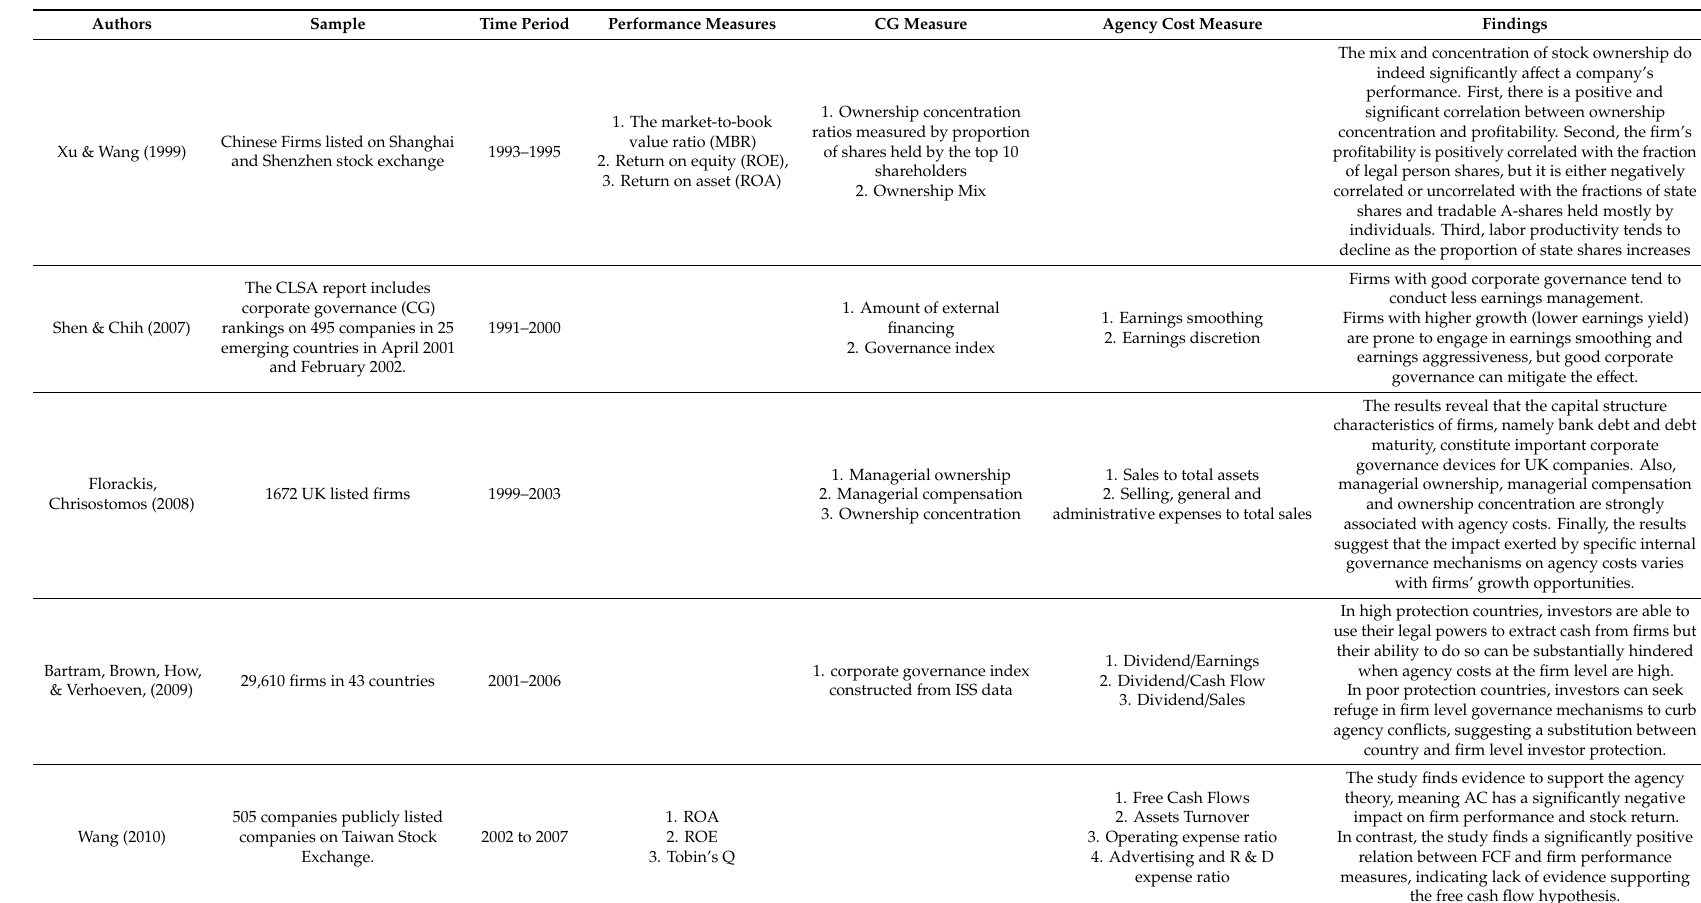
Table A1. Correlation between agency cost, corporate governance and the firm